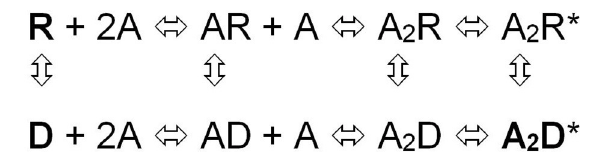
FIGURE 2 | Sequential model of the nAChR activation equilibrium. The model considers that each state of channel activation has a corresponding desensitized state (Dilger and Liu, 1992): R is the nAChR in the resting state, A the agonist and RA and RA2 represent the nAChR with one or two agonist molecules bound, respectively, and RA2* is the biliganded nAChR in a transient active open configuration; D, AD, A2D, and A2D* are the corresponding isoforms in the desensitized, non-conductive states, respectively. This allosteric equilibrium can be affected e.g., by single-point mutations and exposure to some drugs (From Fernández Nievas et al., 2008).